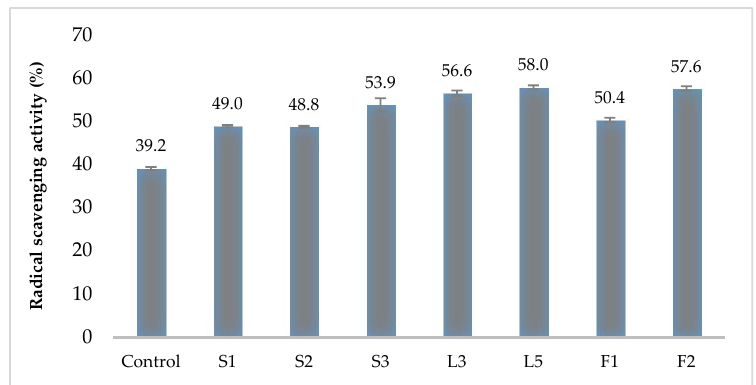
Figure 3. Radical scavenging activity of LAB strains isolated from industrial Kombucha. Data shown are mean ± SD of triplicate values of independent experiments.